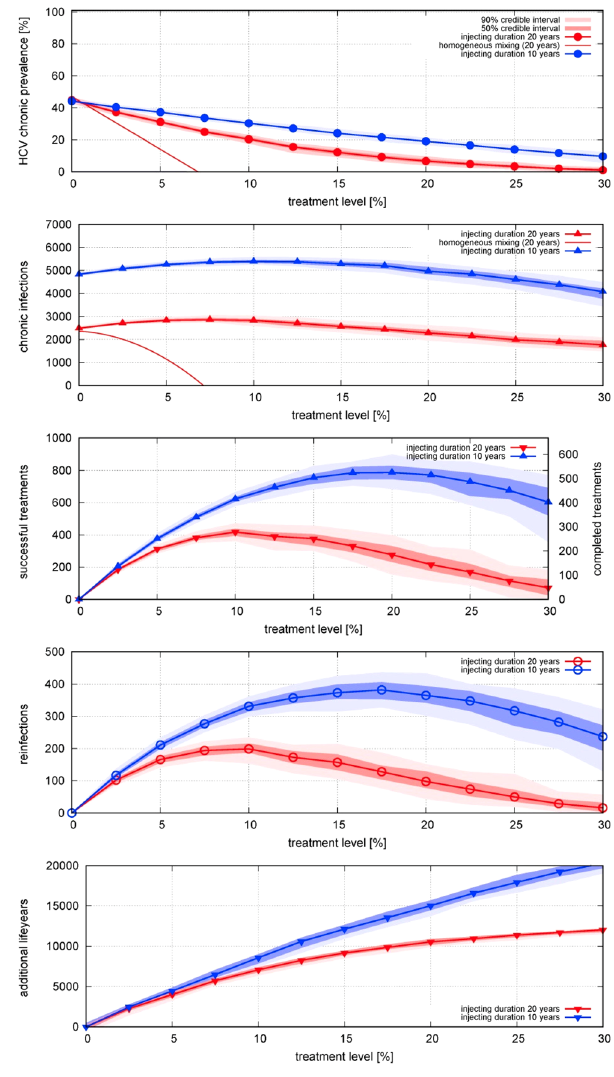
Figure 5. Comparison of injecting career duration of 20 years (red) and 10 years (blue) for the ec-network on the effect of different treatment rates on equilibrium ( A ) prevalence of HCV infection; incidence per year of ( B ) chronic infection (including arising from reinfection), ( C ) cured by successful treatment, ( D ) reinfection; and ( E ) life-years gained, for treatment rates varied from 0 to 30% per year. For the shorter injecting career duration, the number of individuals entering and leaving is twice as high (100/year) for a system of the same size (1000 individuals). The infection rate has been fitted to obtain 43% prevalence of chronic infection in the absence of treatment ( α is 1.3 times the one for 20 years). For an infection duration of 10 years (close to the assumption in ref. 22), treatment is much less effective in reducing